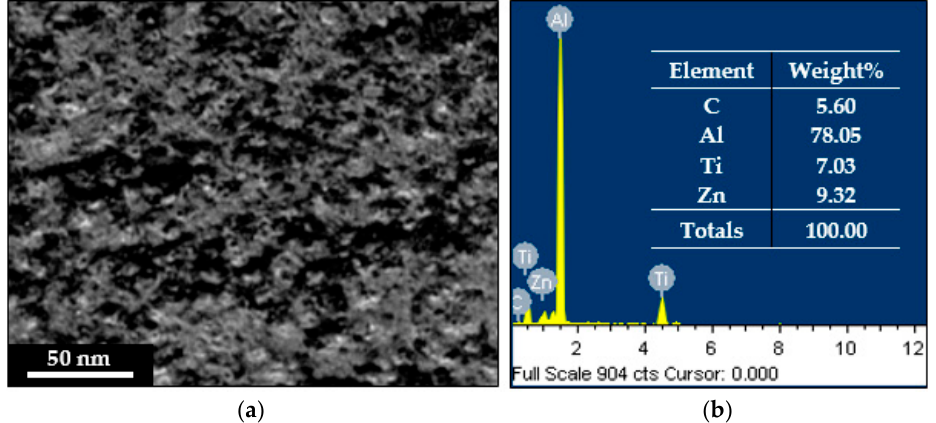
Figure 4. Morphology characterization of Al–12 wt.% TiC nanocomposite sample ( a ) FESEM micrograph, ( b ) EDX elemental analysis.